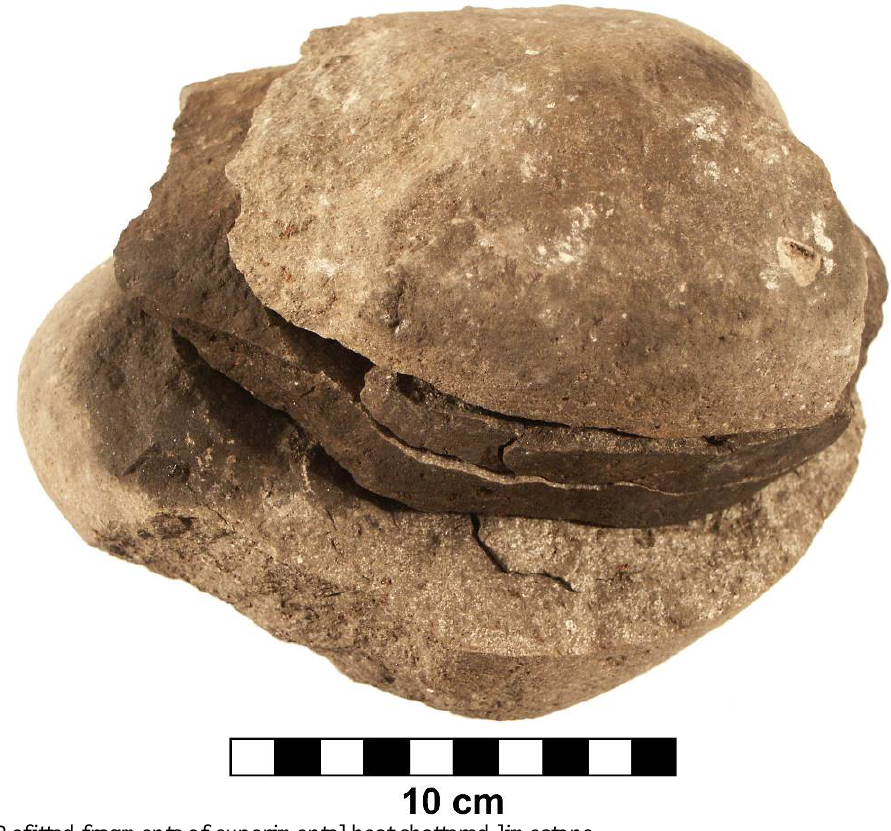
Figure 21. Refitted fragments of experimental heat shattered limestone.